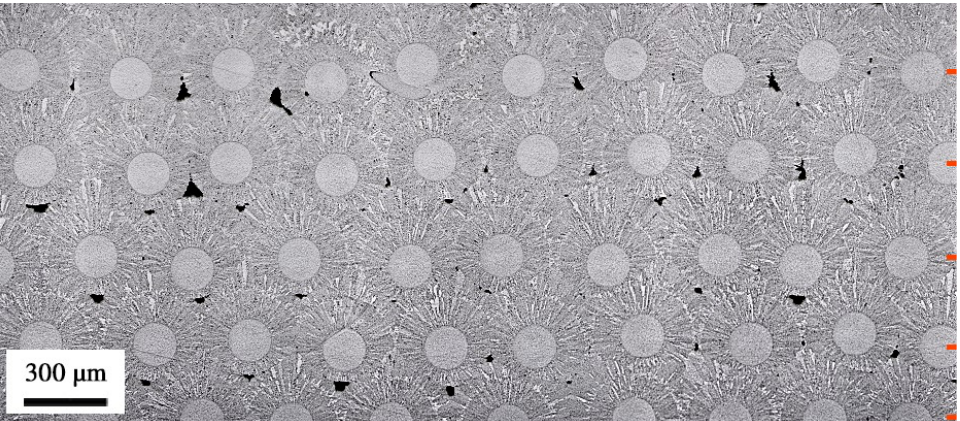
Figure 11. Metallographic polish of an improved W f /W sample sliced perpendicularly to the warp fibers. The CVD parameters used were P tot = 12 kPa, T Heater = 773 K, ˙ V inlet ˙ V inlet = 2500 sccm. It should be noted that for a different CVD device or other geometries, these H 2 parameter values need to be recalculated via the presented model.